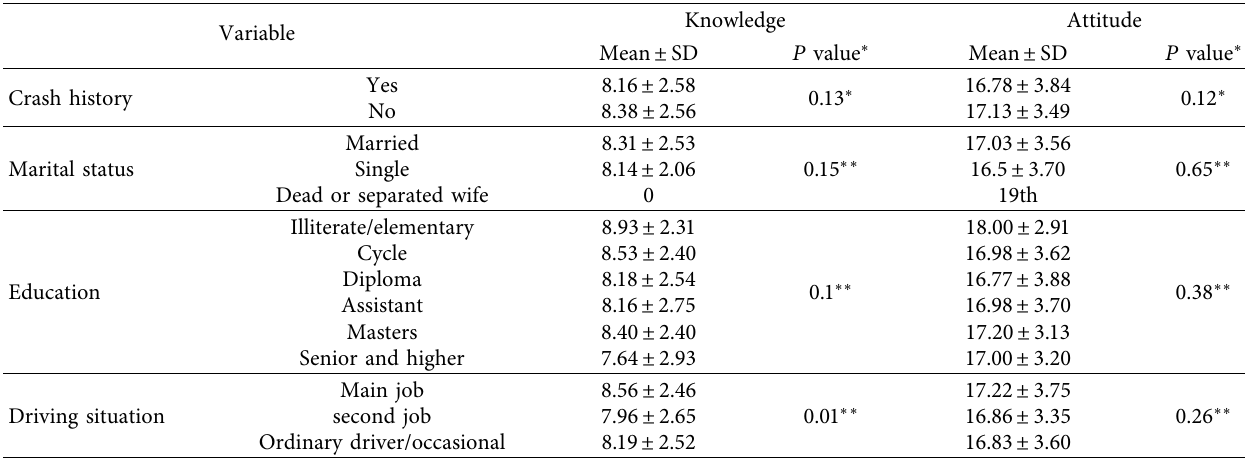
Table 4: Determining the relationship between variables (gender, marital status, education, and accident history) with mean score of knowledge and